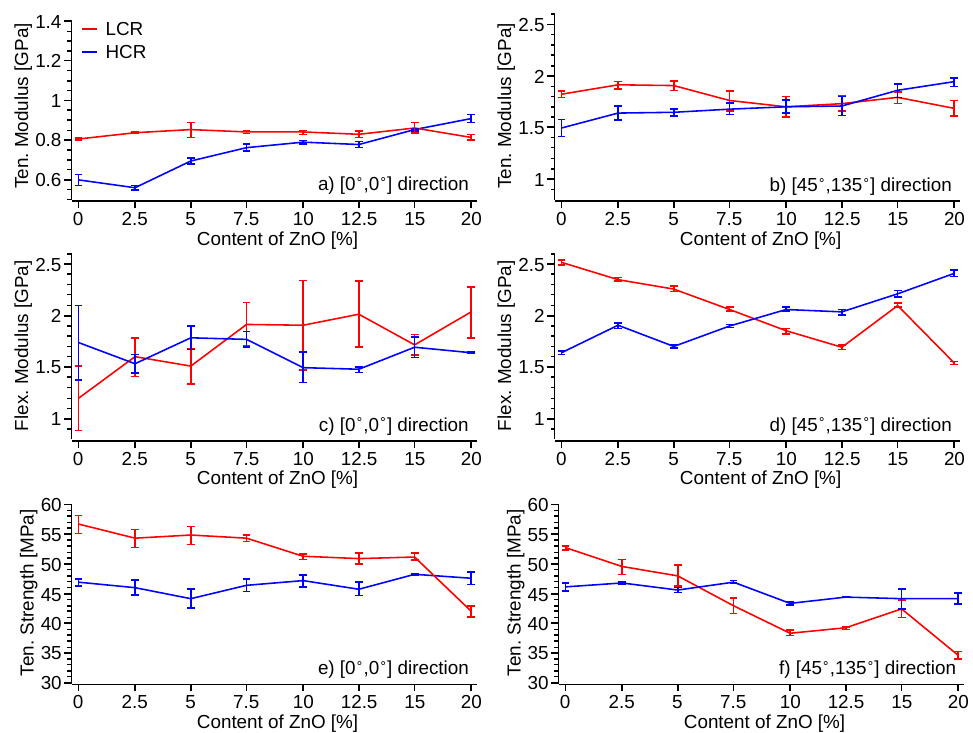
Figure 10. Average tensile and flexural test results of specimens 3D printed with HCR (blue) and LCR (red). Elastic modulus from tensile test ( a ) [0°, 0°] infill direction, ( b ) [45°, 135°] infill direction, flexural modulus from three-point bending ( c ) [0°, 0°] infill direction, ( d ) [45°, 135°] infill direction, tensile strength of 3D printed specimens with ( e ) [0°, 0°] infill direction, and ( f ) [45°, 135°] infill